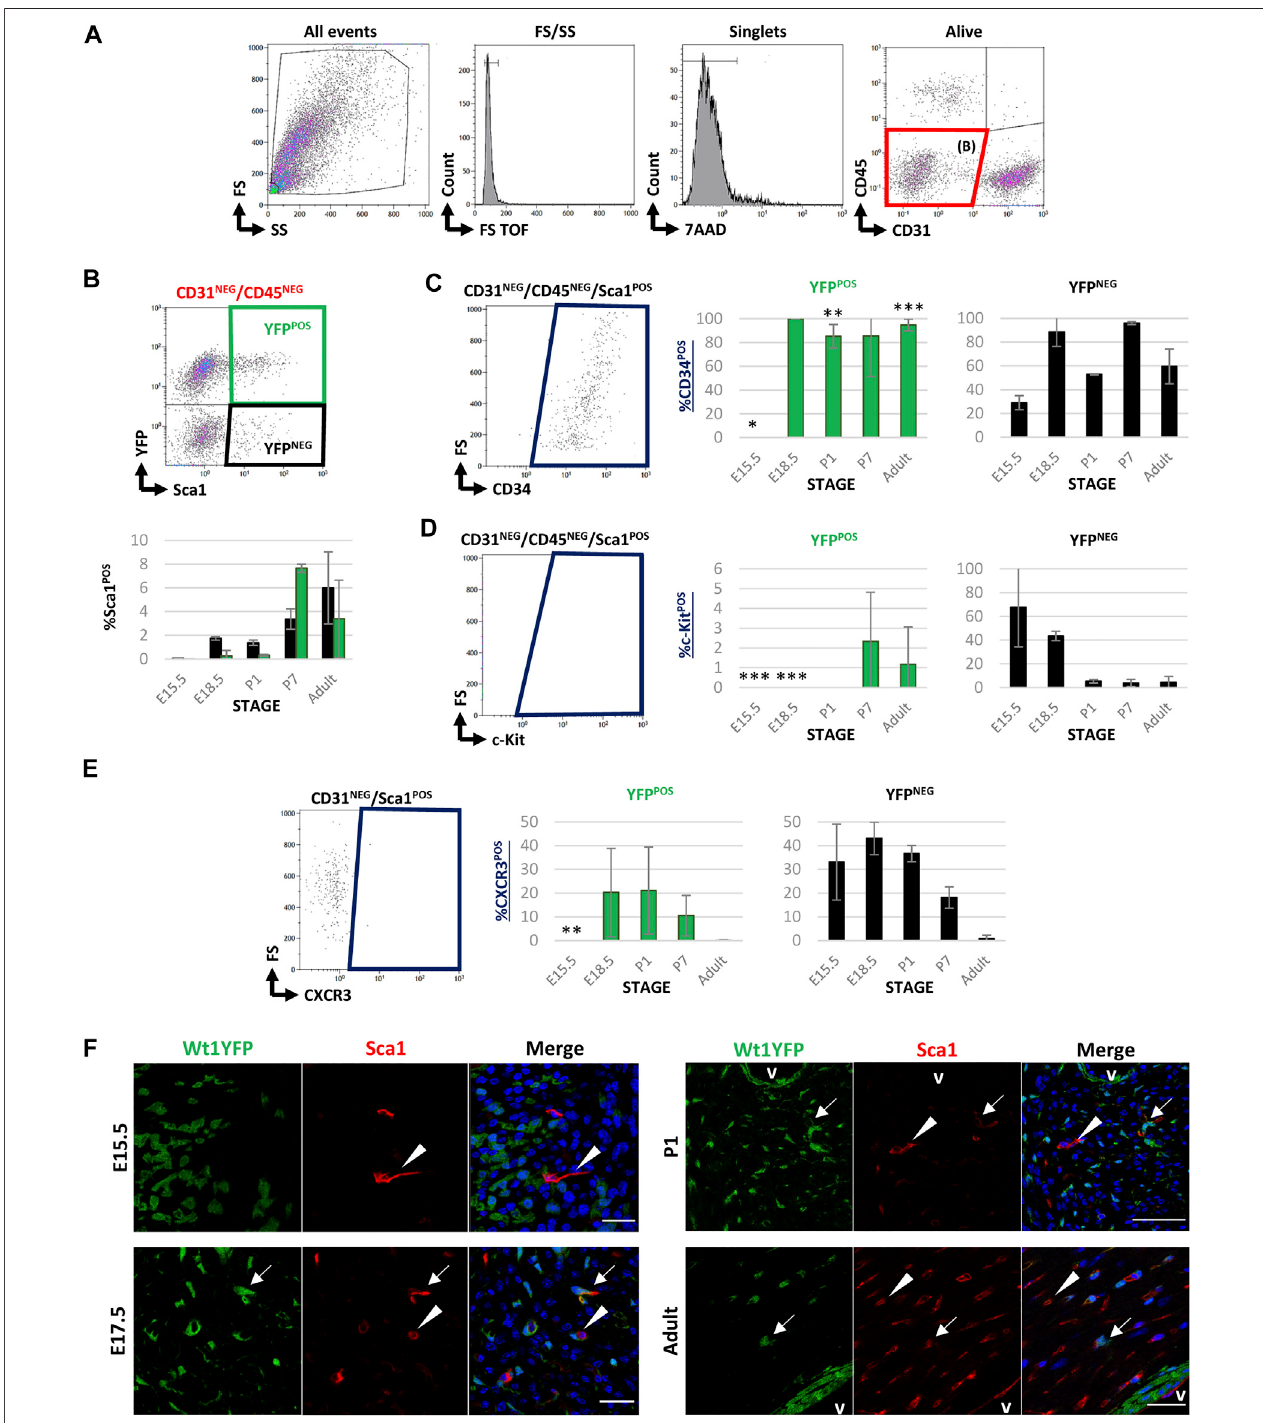
FIGURE 3 | FACS characterization of cardiac Sca1 POS cells during development and adulthood in Wt1Cre-YFP mice. (A) Representative dot blots and cytograms from theFACS analyses show thesequential gating used forthecharacterizationofCD31 NEG /CD45 NEG cardiac interstitialcells. (B) Representativedot blotofthegating used for the characterization of Sca1 and YFP within the CD31 NEG /CD45 NEG cells subpopulation. This same gating was used in all the stages considered in this study (upper row). The bar plots representing the percentages of CD31 NEG /CD45 NEG /Sca1 POS cells present in all the stages considered in this work (E15.5, E18.5, P1, P7,andadult).YFP POS (greenbars)andYFP NEG (blackbars)areidenti fi ed(lowerrow). (C) RepresentativedotblotforthecharacterizationofcardiacCD34 POS cellswithin the CD31 NEG /CD45 NEG /Sca1 POS subpopulation (left). The bar plots illustrated the percentage of CD34 POS cells within the CD31 NEG /CD45 NEG /Sca1 POS /YFP POS (green bars, middle) or YFP NEG (black bars, right) subpopulations, respectively. (D) Representative dot blot for the characterization of c-Kit POS cells within the CD31 NEG /